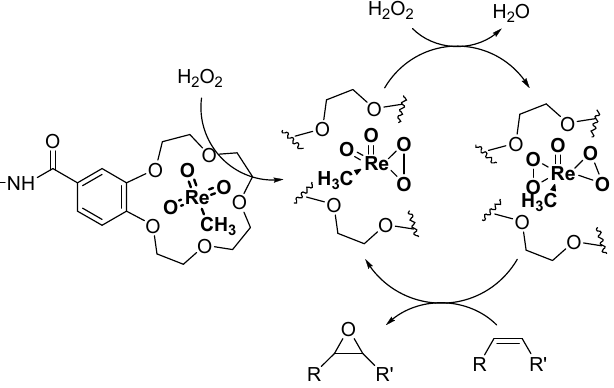
Scheme 13. Synthesis of 2nd generation PAMAM